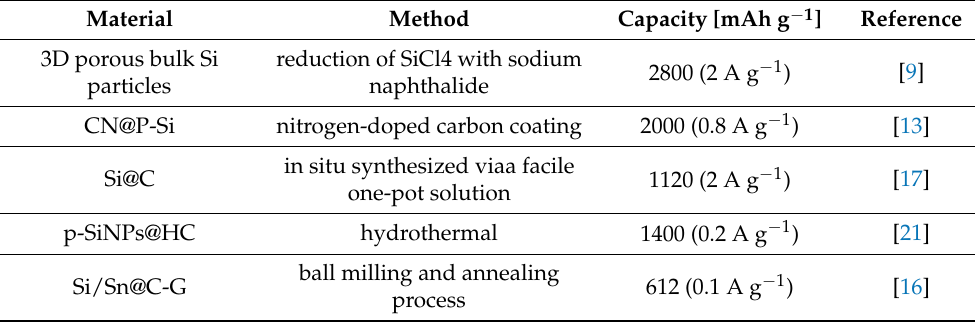
Table 1. Comparison of the performance of different materials and